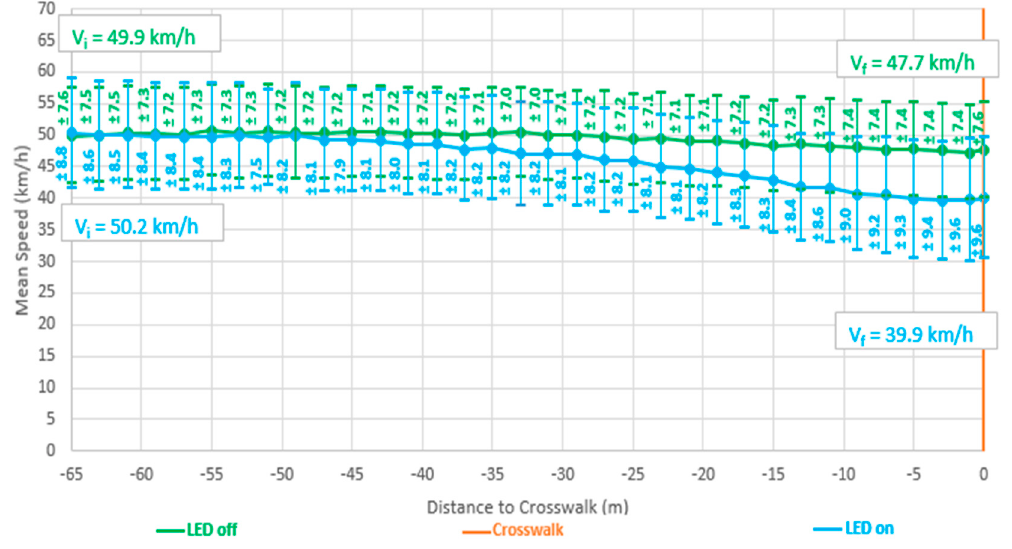
Figure 6. Mean speed profiles (No Pedestrian).